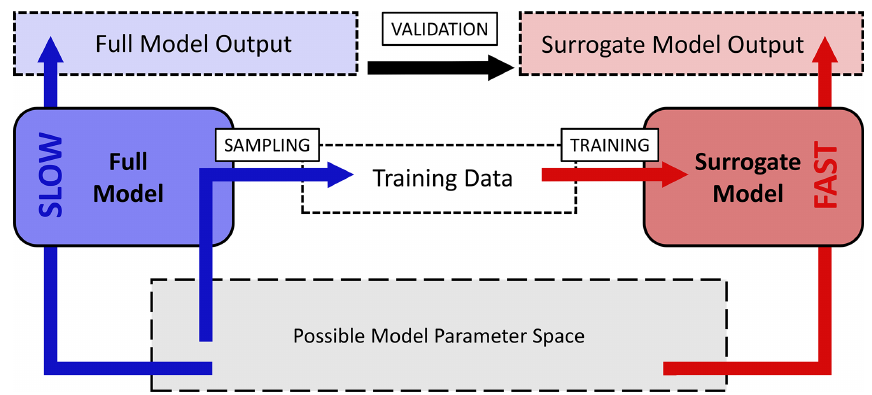
Figure 1. Workflow chart for the surrogate-modeling process employed in this study. The possible or desired model parameter space (gray) is sampled with the slow-computing full model (blue) to acquire training data consisting of model input–output pairs. Training data are used for training of a fast-computing surrogate model (red). Surrogate models are validated by comparison of full-model output and surrogate-model output. Table 1. KM-SUB input parameters with lower and upper boundaries and fit parameters to the laboratory dataset. Parameter Lower boundary Upper boundary Description k SLR 1 . 0 × 10 − 15